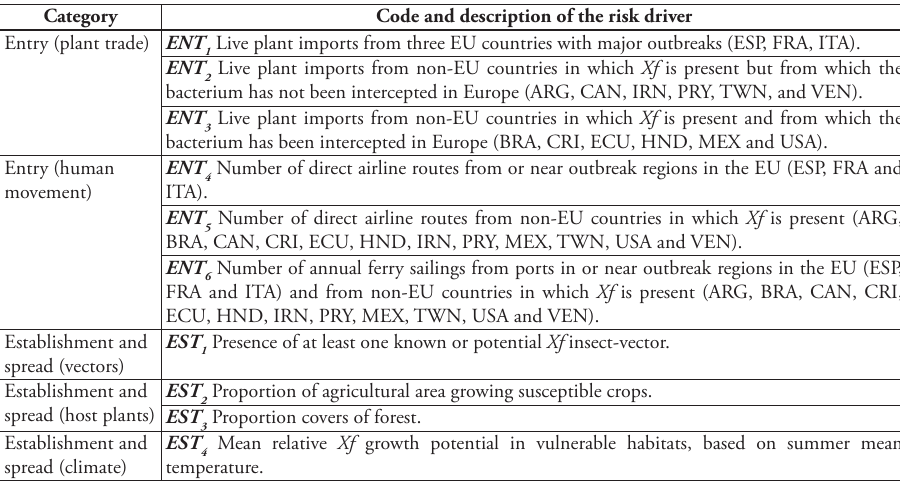
table 1. Risk drivers used to assess overall Xylella fastidiosa invasion risk and their weights. Category Code and description of the risk